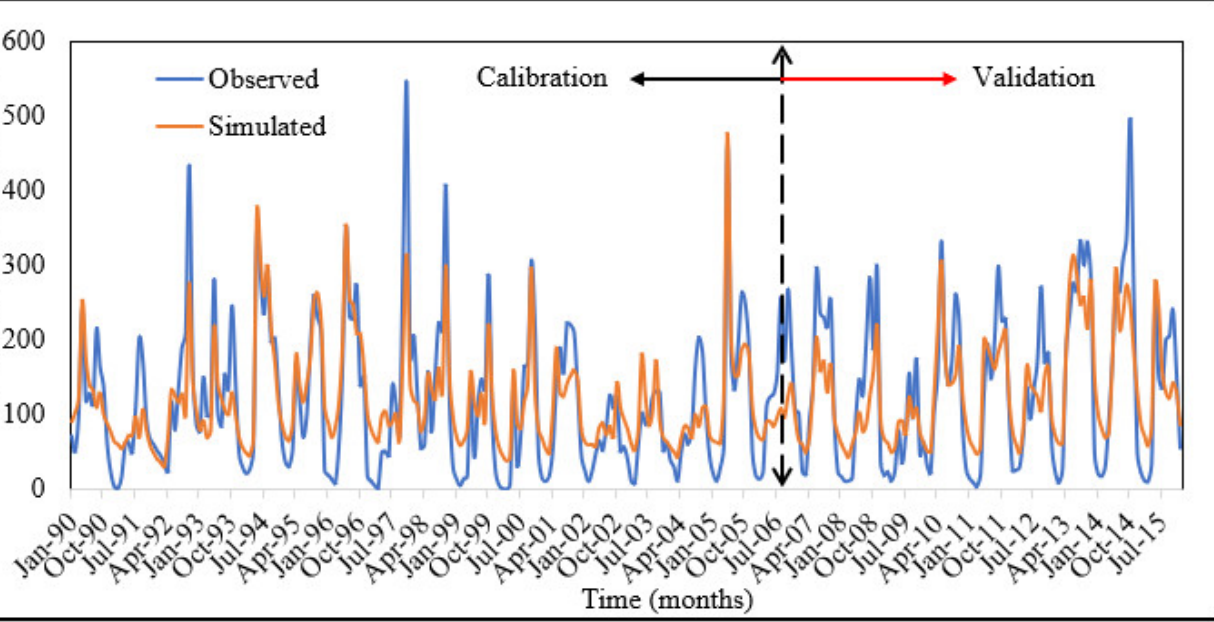
Table 6. The statistical properties index value for monthly streamflow calibration and validation processes and model uncertainty measurements.